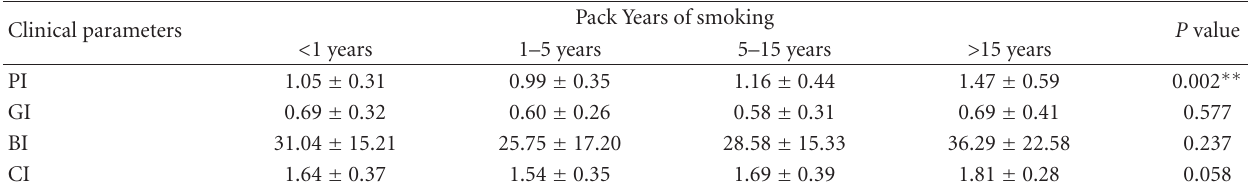
Table 14: Mean pattern of clinical parameters with years of smoking.